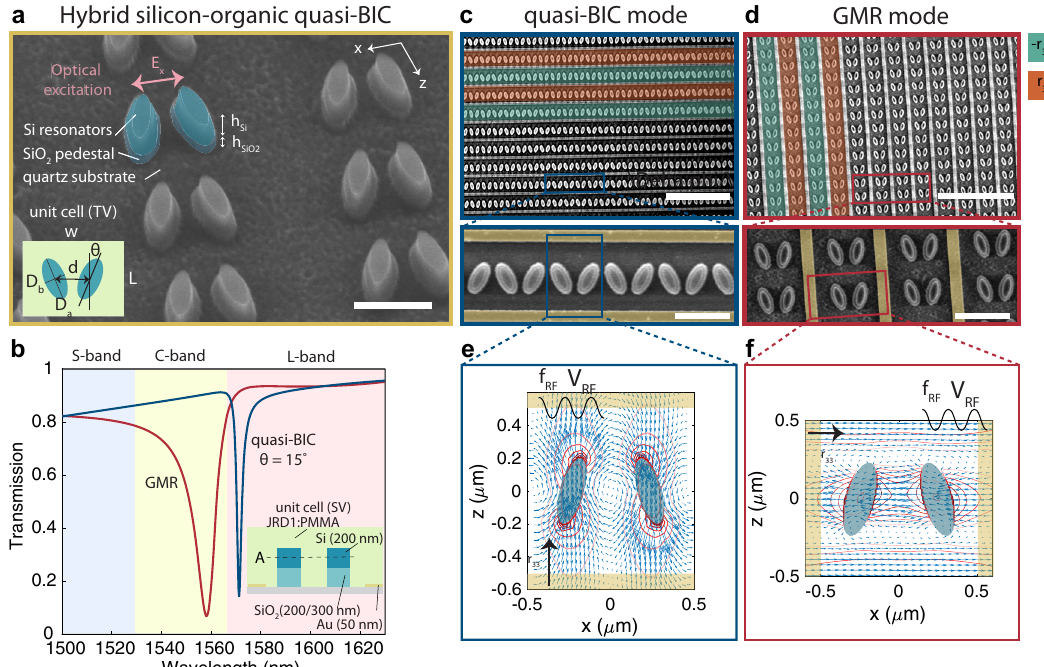
Fig. 2 Hybrid silicon-organic free-space electro-optic modulators based on Mie resonances for C- and L-bands. a A single electro-optic modulator is made from a rectangular array of silicon nanoresonators patterned onto a quartz substrate on top of a silicon dioxide pedestal, here shown prior to the deposition of the metallic electrodes and the organic electro-optic layer (green) which is applied post-fabrication by spin-coating and covers the nanoresonators. Inset shows the top view (TV) of one single unit cell. Scale bar = 500 nm. This geometry can sustain two distinct types of resonances, quasi-bound states in the continuum (quasi-BICs) and guided-mode resonances (GMR), shown in b , with corresponding geometries as in c , d . Inset shows the side view (SV) of one unit cell. The two types of resonances are excited by an incident beam that is x -polarized and have distinct distributions of the near- fi elds of the resonators, shown in e , f (cross-section A of SV). While the quasi-BIC mode is circulating in the near fi eld and has a dominant component along the z -axis (hence perpendicular to the excitation polarization), the guided-mode resonance is predominantly x -polarized (as the excitation). Given this vectorial orientation of the optical fi elds in the near fi eld of the resonators, metallic electrodes are deposited in between each row of ellipses and are oriented along the x -axis for the quasi-BICs and along the z -axis for the GMR, as shown in b , c (scale bars upper picture = 5 μ m and lower pictures = 1 μ m). The interdigitated electrodes serve for the activation of the JRD1:PMMA layer by electric fi eld poling and for the application of DC and RF tuning fi elds. Black arrows indicate poling